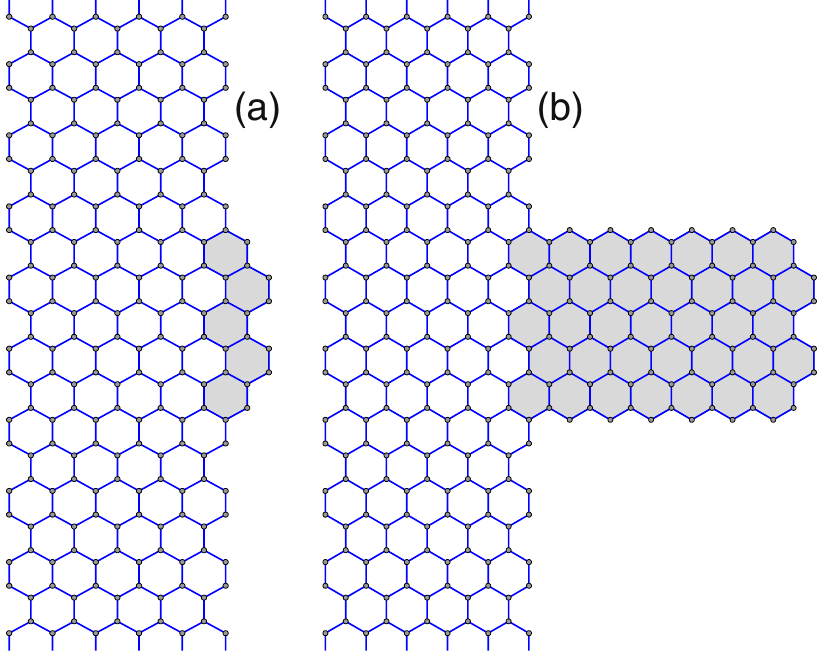
Figure 3. Example of an armchair graphene nanoribbon with an edge pillar defect: a small piece of a carbon structure is attached perpendicular to the nanoribbon. Width of the main nanoribbon is D a = 1.228 nm, width of the zigzag nanoribbon is D z = 1.134 nm, length of the edge pillar is ( a ) L p = 0.246 nm and ( b ) L p = 1.719 nm. Gray color marks a change of the lattice structure of the ideal armchair nanoribbon.